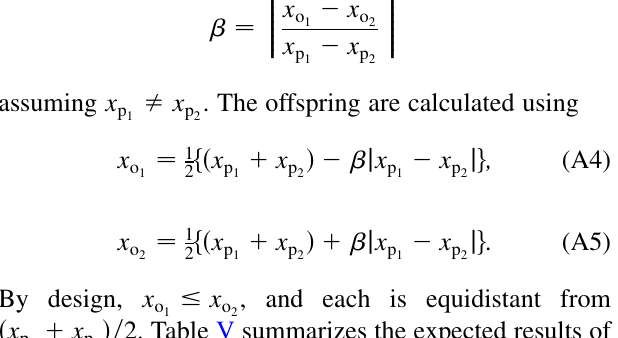
FIG. 28. Probability density functions used in polynomial mu- tation: (a) when the independent variable domain is uncon- [Eq. (A1)]; (b) when the strained for three values of (cid:7) mut independent variable domain is restricted to x L (cid:2) x (cid:2) x